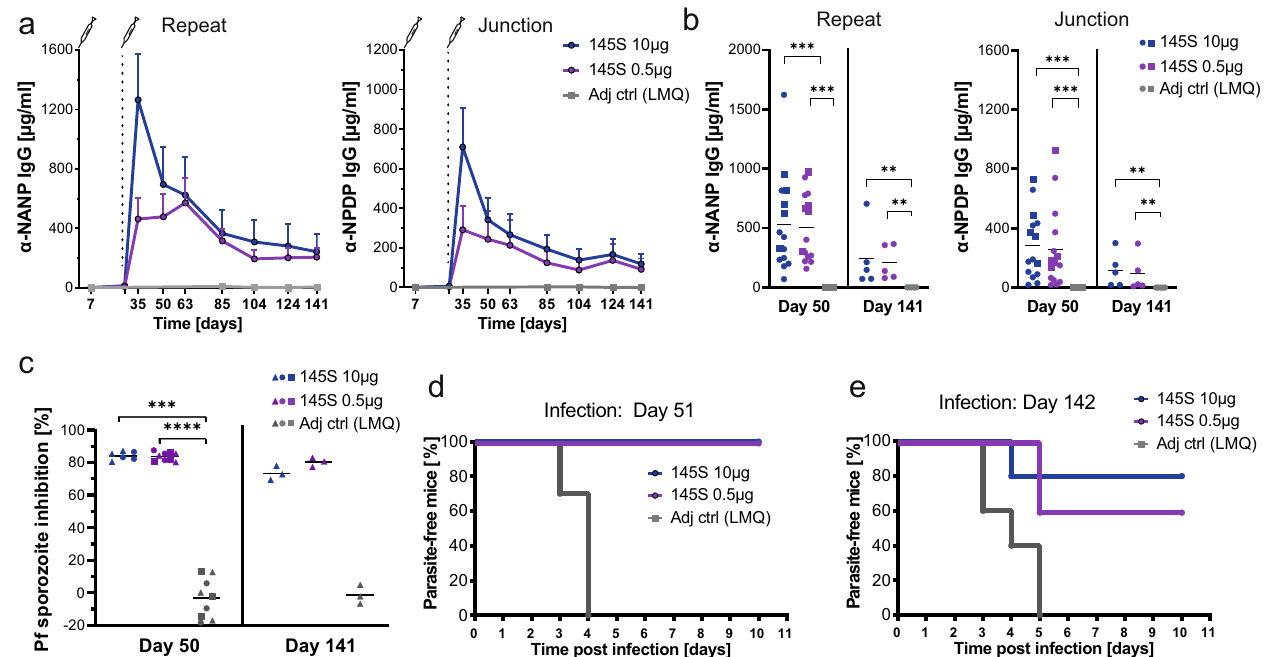
Fig. 5 The glycosylated nanoparticle 145S confers long-lived protective antibody responses. a C57BL/6J mice were immunized with 10 µg or 0.5 µg immunogen 145S adjuvanted with LMQ or with LMQ alone at day 0 and 28. The serum IgG response against the repeat (NANP) and the junction (NPDP) was measured at different timepoints. One representative out of two independent experiments with 10 mice per group is shown until day 50. Day 51 until day 141 shows data from one experiment with 5 mice per group. b Anti-repeat (NANP) or junction (NPDP) IgG response at day 50 and day 141 after the fi rst immunization. Dots represent individual mice. Day 50: Pooled data of three independent experiments with 5 mice per group are shown. Day 141: Data of one experiment with 5 mice per group is shown. Symbols indicate independent experiments. c Capacity of pooled sera (diluted 1:800) collected 50 days or 141 days after fi rst immunization to inhibit the hepatocyte traversal activity of Pf sporozoites in vitro. Pooled data of three independent traversal assay experiments are shown. Symbols indicate independent immunization experiments. d , e Capacity of immunization with immunogen 145S at two different doses to protect mice after PbPfCSP(mCherry)-infected mosquito bite challenge (3 bites per mouse) from parasitemia. Data show the percentage of blood stage parasite-free mice over time. d Day of challenge 51: Pooled data of two independent experiments with 5 mice per group are shown. e Day of challenge 142: Data from one experiment with 5 mice per group. Arithmetic mean ( a – c ) and SEM ( a ) are indicated. Statistically-signi fi cant differences were calculated by two-tailed Mann – Whitney test (* P < 0.05; ** P < 0.01; *** P < 0.001, **** P < 0.0001). Statistically non-signi fi cant differences are not